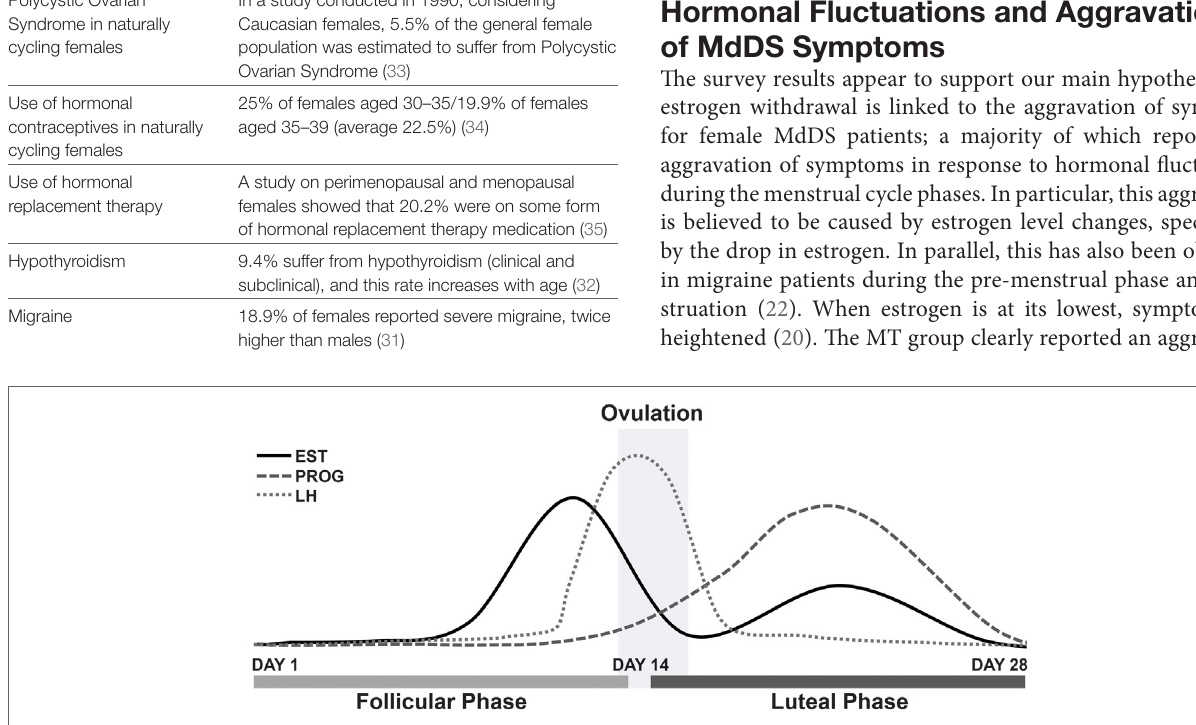
Table 8 | Normative data from previous studies of the US population, which correspond to the focal points of this study. Regular menses in naturally Distribution of the regularity and length of cycling females menstrual cycles among 4900 females aged 34–45—12% had irregular menses (36)